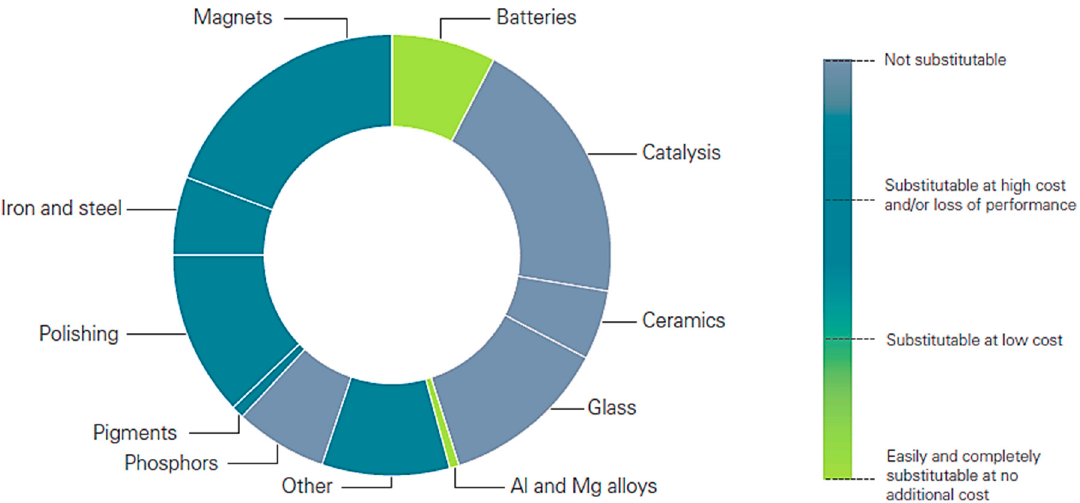
Figure 5. Current consumption of REEs in several applications, as well as the respective susceptibility to be replaced [22] .